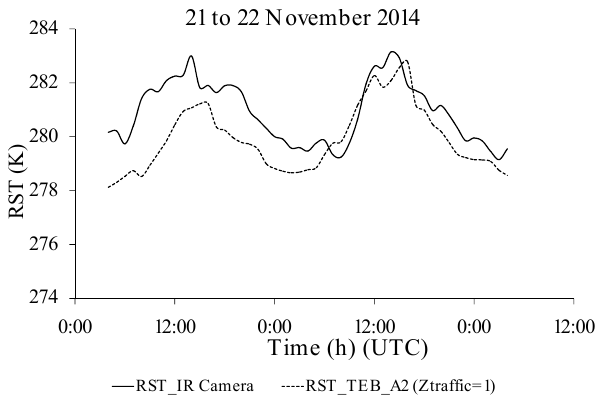
Figure 12. Comparison between RST from TEB via the sec- ond approach (RST_TEB_A2), RST from TEB via the second approach without buildings (RST_TEB_A2_WB) and field data (RST_measured) for the first